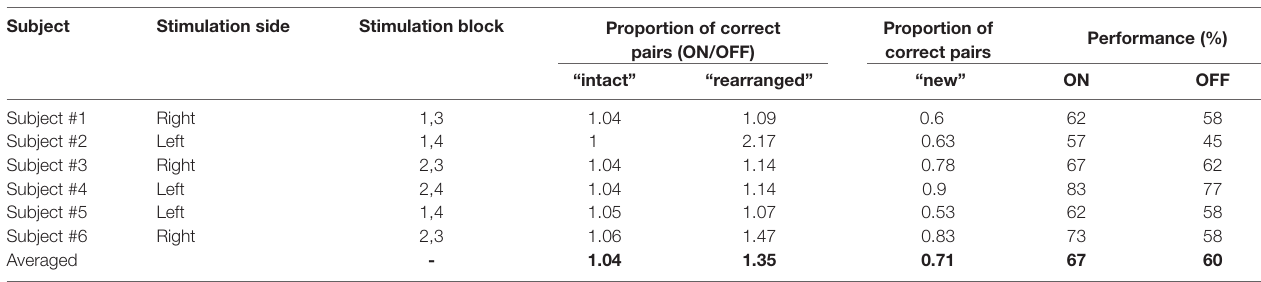
TABLE 2 | Word pair memory task behavioral results.